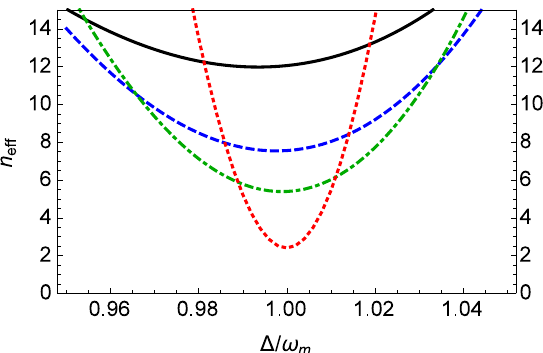
Figure 2. The effective mean phonon number n ef f of the movable mirror versus the normalized effective cavity detuning ∆ / ω m for different reflection coefficients r = 0 (black solid), 0.2 (blue dashed), 0.3 (green dot-dashed), 0.46 (red